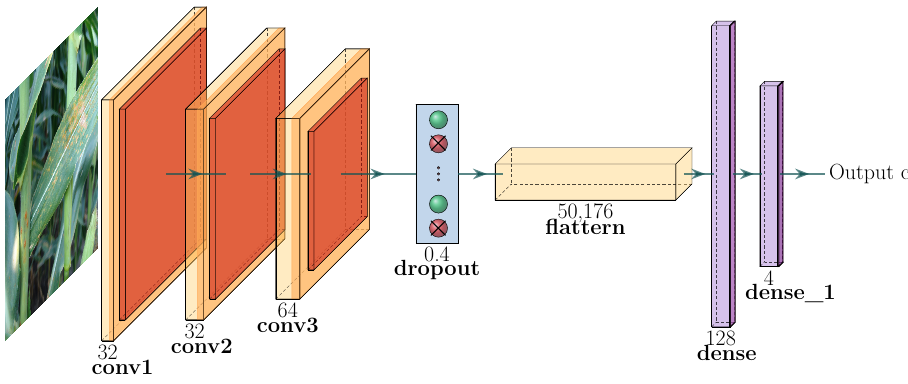
Figure 6. Architecture of the shallow CNN model for simultaneous maize leaf disease classification and quantification. From the left, the maize leaf image is processed by three convolutional layers that learn the disease features. A dropout layer is added to reduce overfitting before converting the feature maps into a 1D array through flattening. Finally, the fully connected layers consist of two dense layers (with a ReLu and softmax transfer function, respectively) to yield the class probabilities. This architecture produces about 6,451,812 trainable parameters. The neural network was drawn using the PlotNeuralNet LaTex package